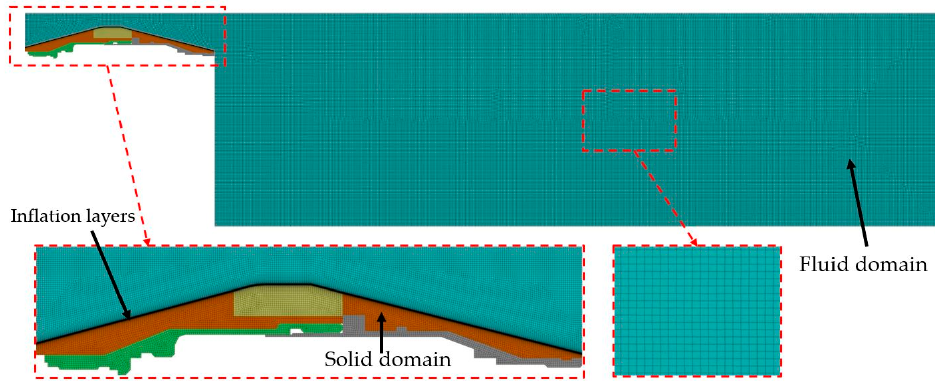
Figure 8. The suitable mesh model of nozzle.